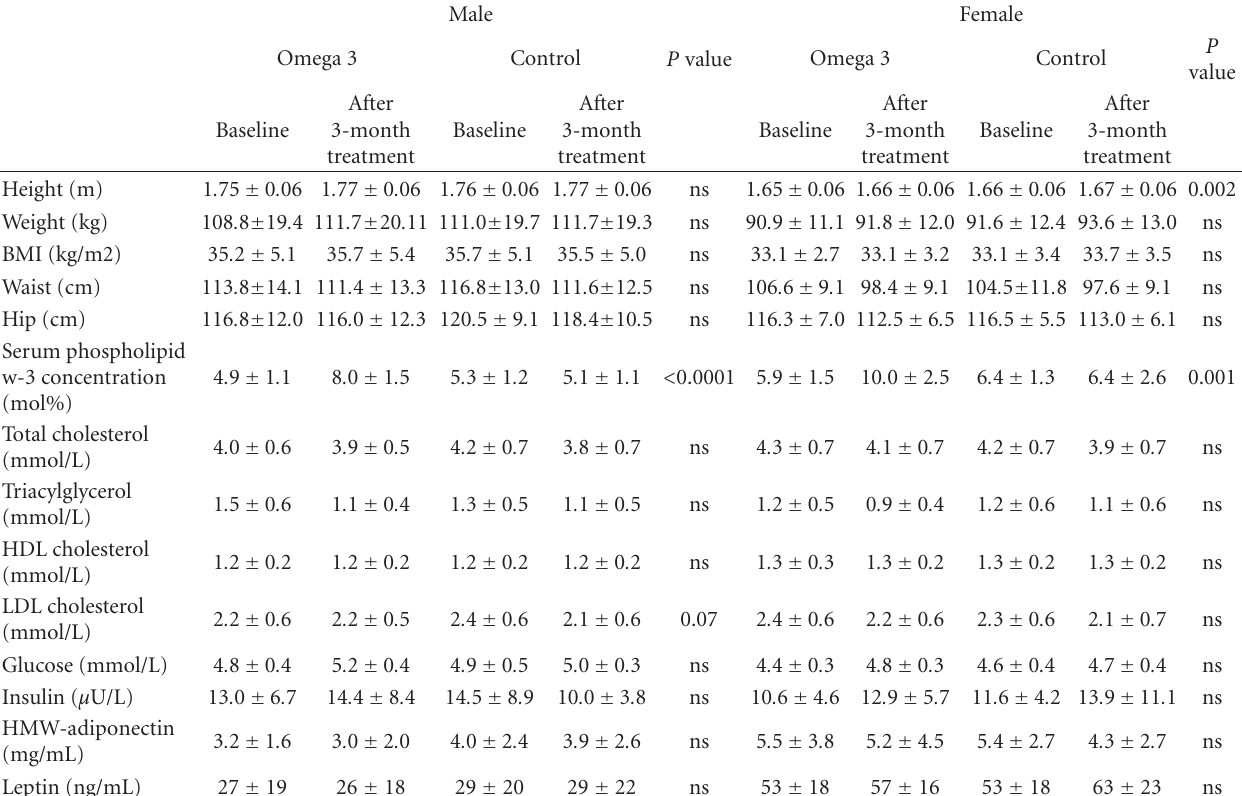
Table 1: Anthropometric and biochemical measures at baseline and after 3-month treatment with n -3PUFAs or placebo in 11 male and 14 female obese